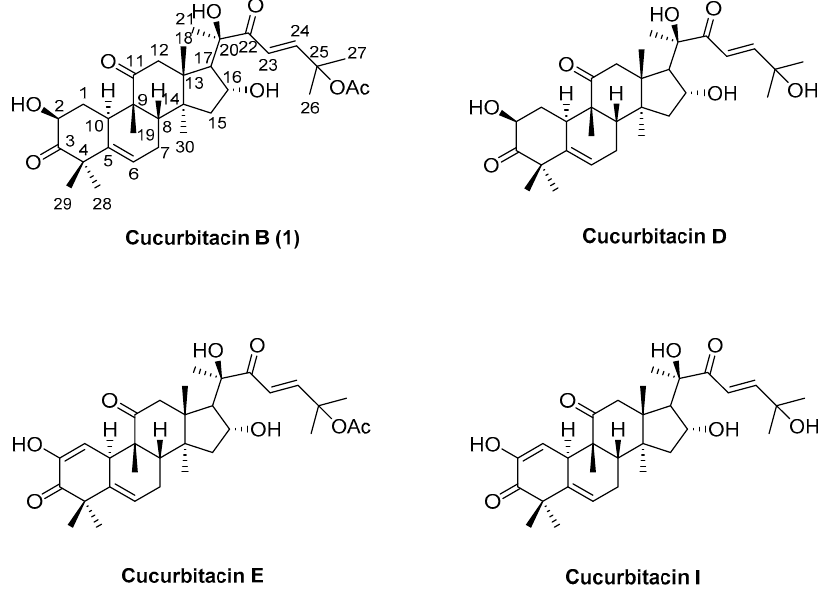
Figure 1. The chemical structures of cucurbitacin B ( 1 ), cucurbitacin D, cucurbitacin E, and cucurbitacin I.